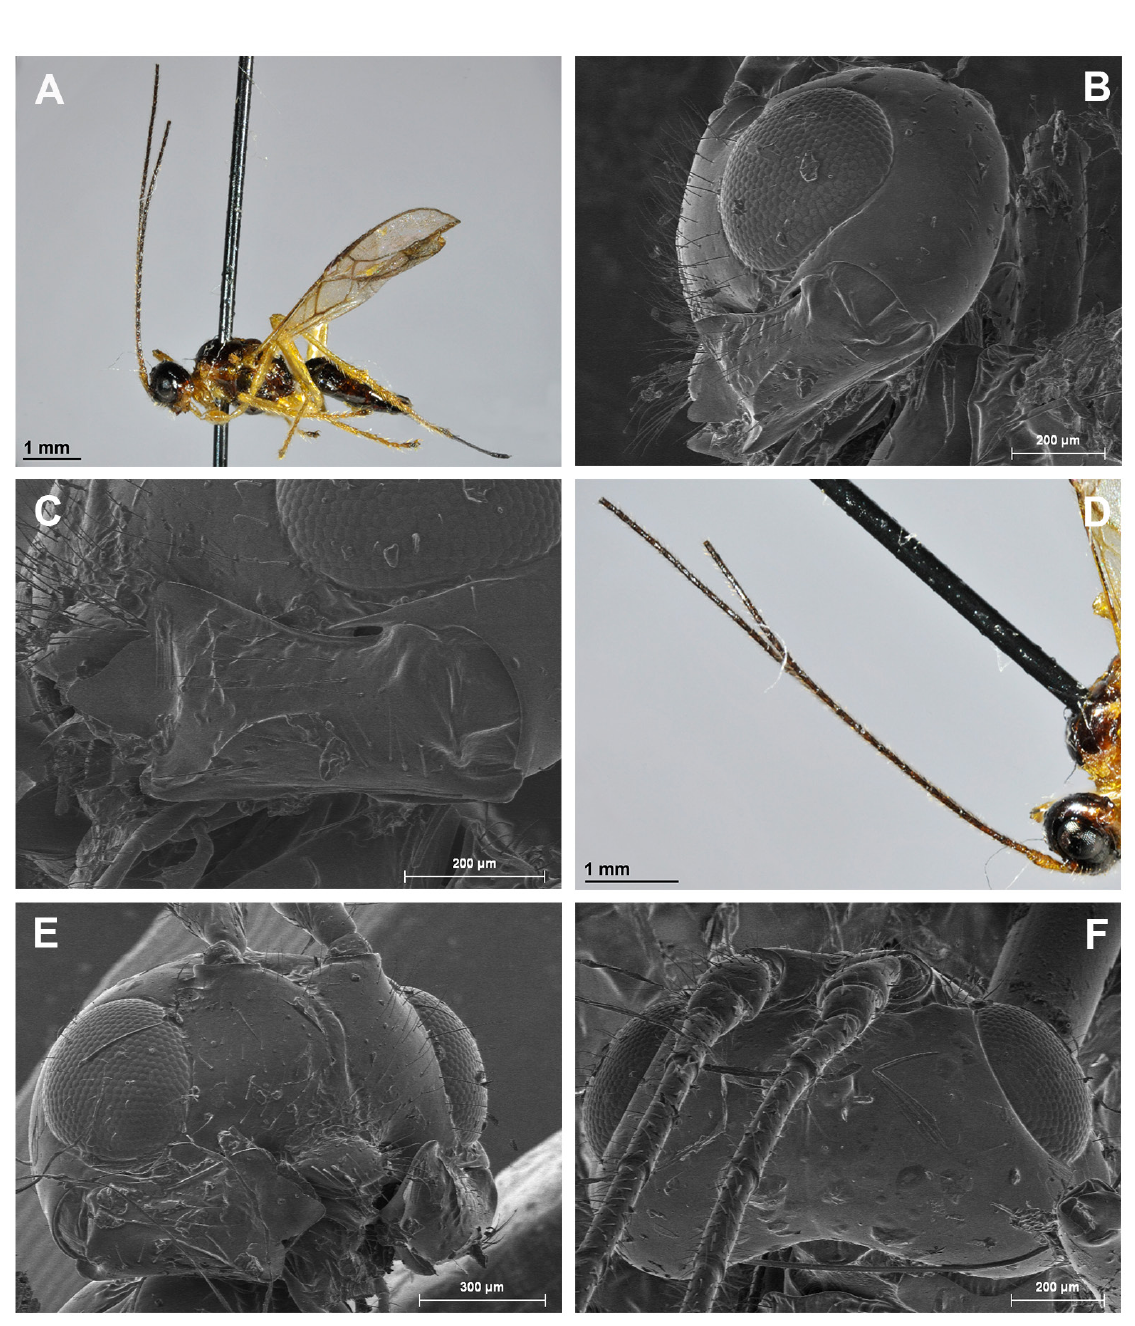
Fig. 68. Asobara ugandensis Fischer, 2007, ♀, holotype (OLML). A . Habitus, lateral view. B . Head, lateral view. C . Mandible. D . Antenna. E . Head, front view. F . Head, dorsal